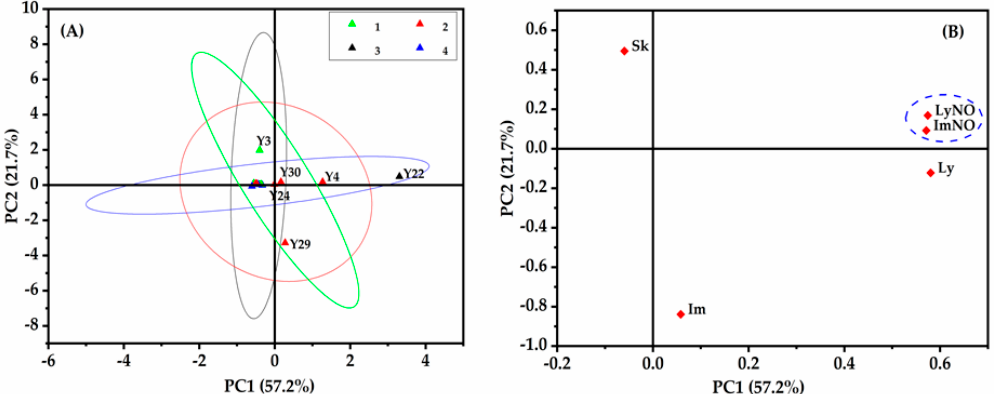
Figure 9. Principal component analysis of A. capillaris with the PAs daily intake above the